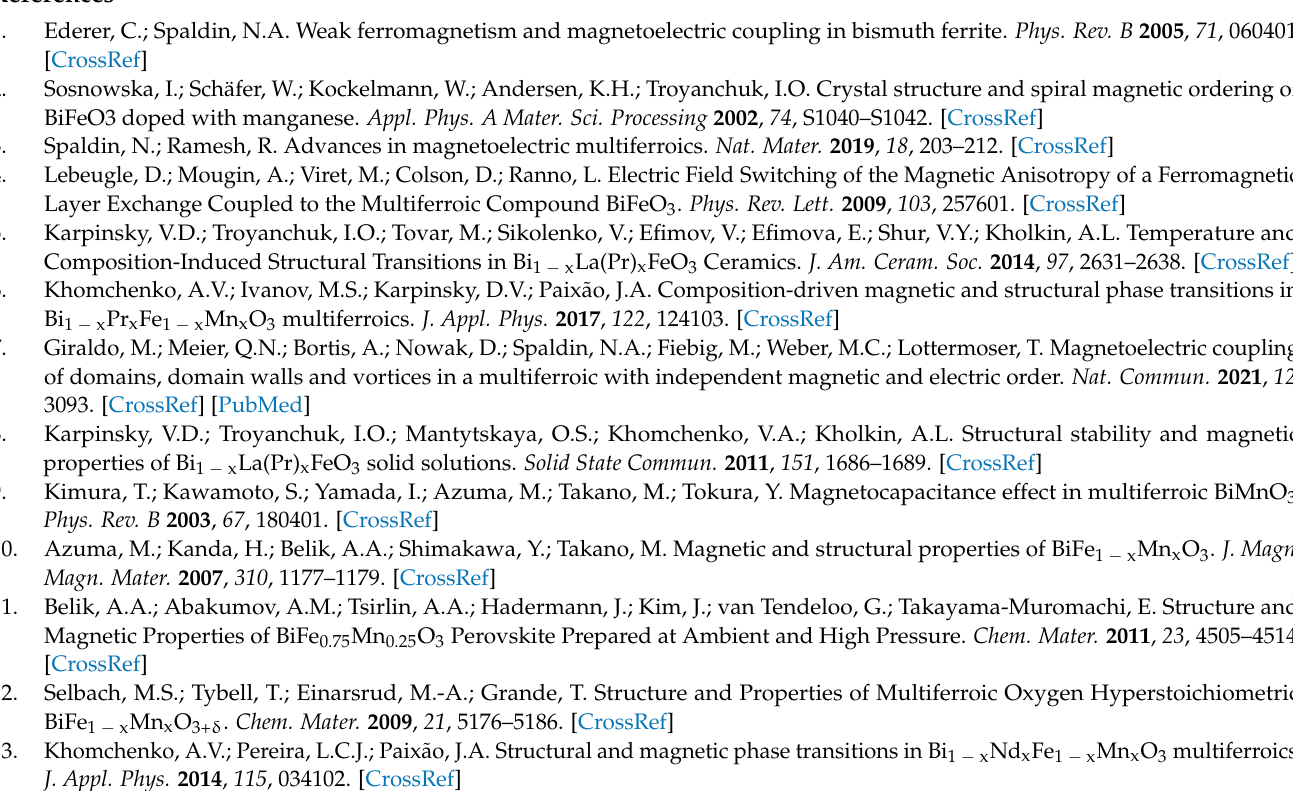
antipolar orthorhombic (O-phase, left image) and the rhombohedral one (R-phase, right image). Figure S2. DSC data for compound BiFe 0.70 Mn 0.30 O 3 . Figure S3: Visualization of the unit cells: the an- tipolar orthorhombic (O-phase, left image) and the mono-clinic one (M-phase, right image). Figure S4: Visualization of the monoclinic unit cell (M-phase). Table S1: Visualization of the monoclinic unit cell (M-phase). Table S2: BiFe 0.50 Mn 0.50 O 3 (as-prepared sample, SPD data refined at T = 300 K). Table S3: BiFe 0.30 Mn 0.70 O 3 (as-prepared sample, SPD data refined at T = 300